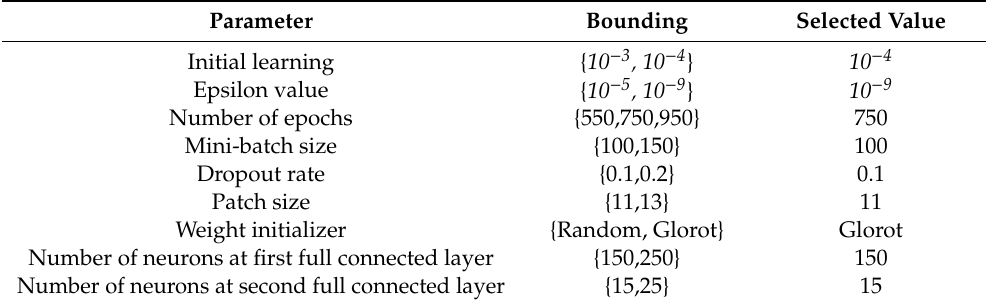
Table 7. The optimum values for the training parameters of the proposed CNN network. Parameter